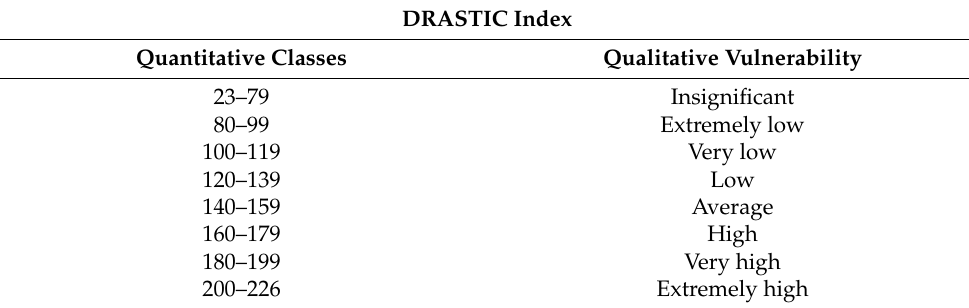
Table 1. Vulnerability classes for the DRASTIC index